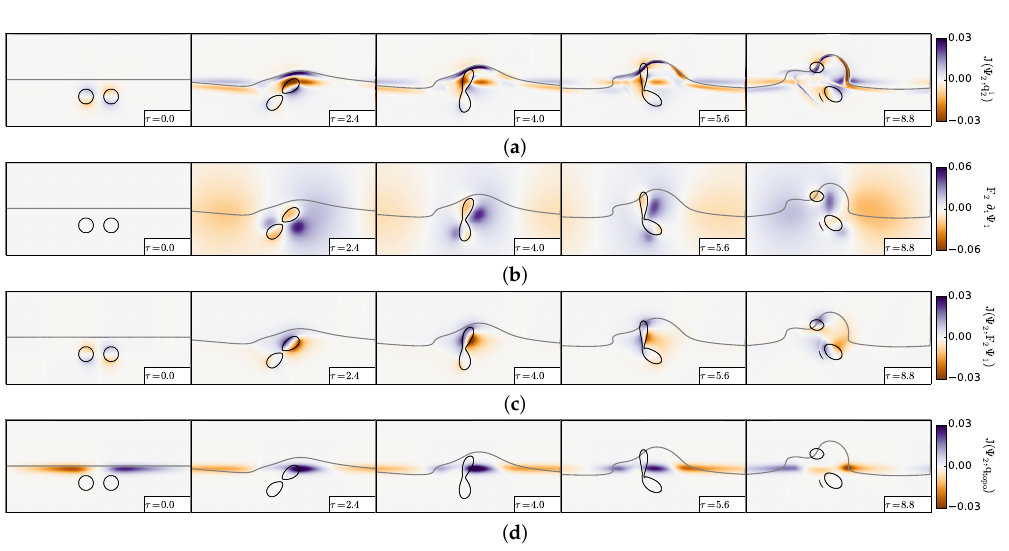
Figure 6. Partial merger of two cyclones, case d / R = 3.4, γ R = 1, d c / R = 2. Analysis of the terms contributing to the rate of change of the lower layer “equivalent barotropic” potential vorticity (Equation (13)): ( a ) lower layer advection of this potential vorticity; ( b ) rate of change of the upper layer flow (via layer coupling); ( c ) baroclinic advection of the barotropic flow (with layer coupling coefficient); ( d ) interaction of the lower layer flow with the topography. In all sub-plots, the black contours indicate the front of lower layer potential vorticity anomaly (straight line at τ = 0) and the upper layer vorticity contours showing the two-cyclone